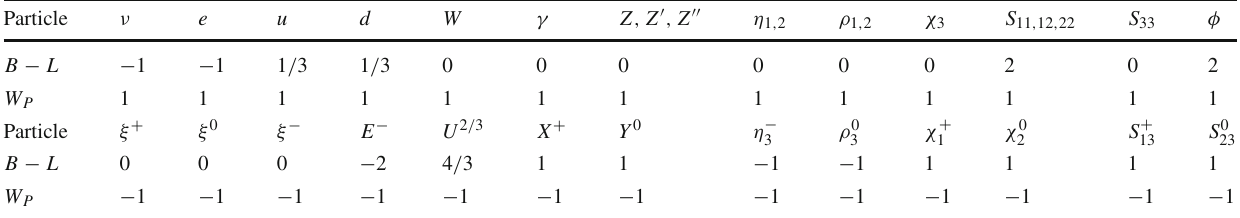
Table 1 The residual gauge symmetry W P separates the model particles into two classes: even particles according to W P = 1 and odd particles according to W P = − 1 Particle ν e u d W γ Z , Z (cid:10) , Z (cid:10)(cid:10) η 1 , 2 B − L − 1 W P